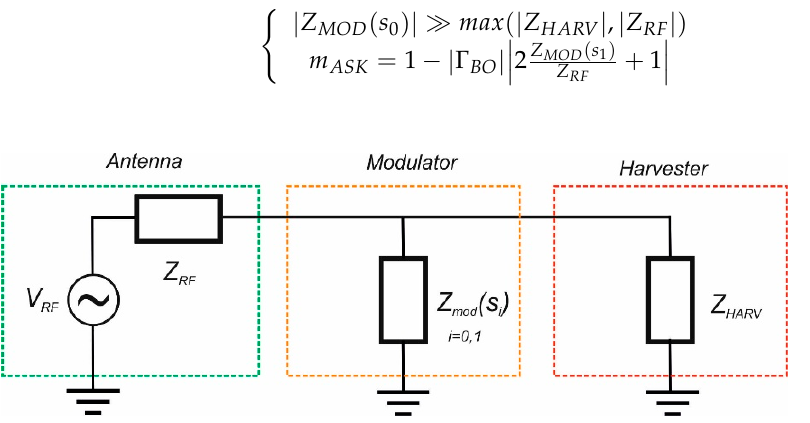
Figure 10. Principle scheme for calculating the impedance conditions for modulator.